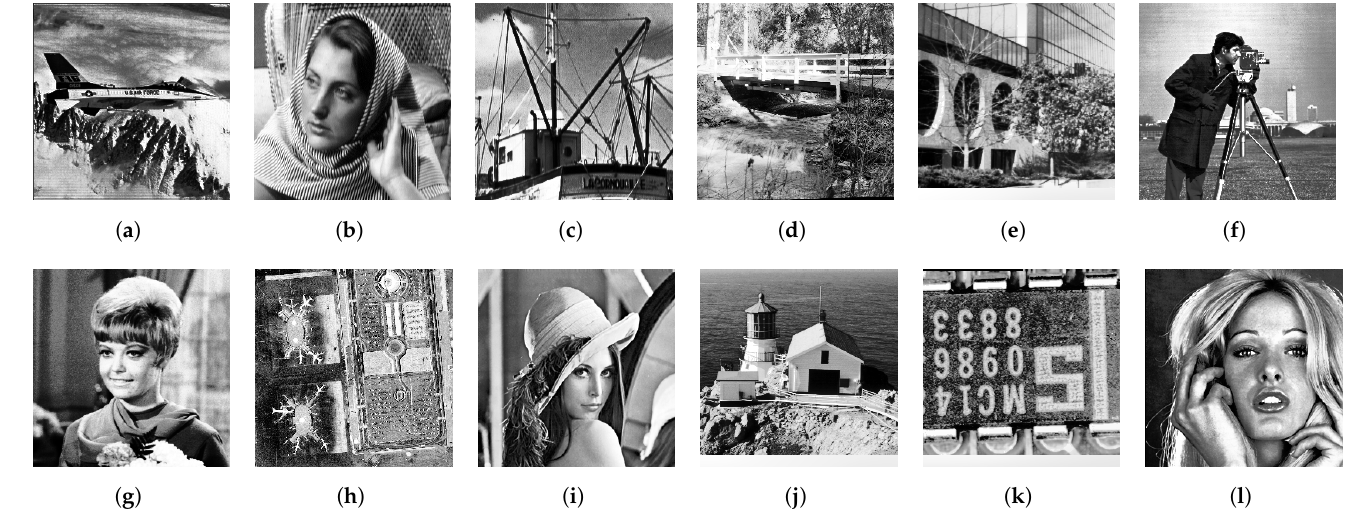
Figure 15. The proposed exact histogram equalization: ( a ) Airplane, ( b ) Barbara, ( c ) Boat, ( d ) Bridge, ( e ) Building, ( f ) Cameraman, ( g ) Girl, ( h ) Lax, ( i ) Lenna, ( j ) Lighthouse, ( k ) Text, ( l )